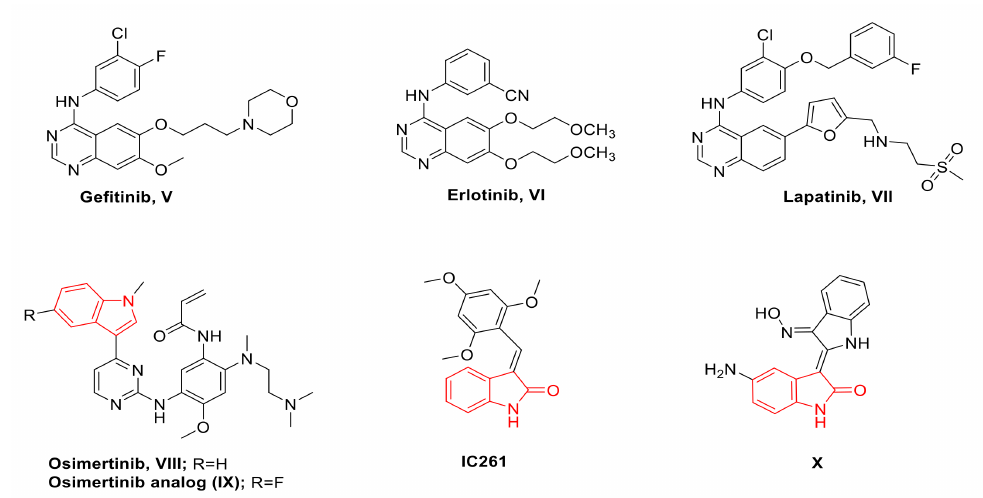
Figure 2. Structures of EGFR and CK1 inhibitors as potent anticancer